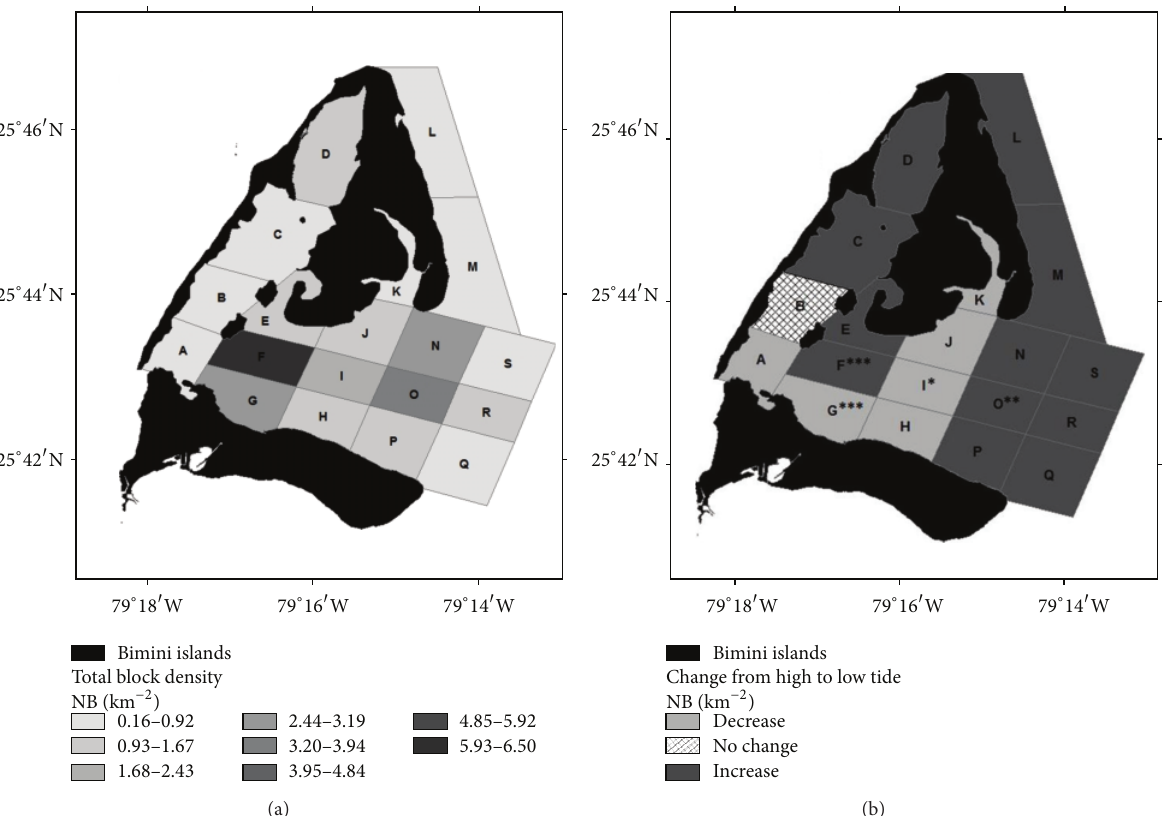
Figure 4: (a) Mean lemon shark block abundance for all surveys conducted; (b) change in block lemon shark count per unit effort (UE) from high-tide to low-tide surveys. Dark grey blocks represent an increase in count per UE; light grey block represents a decrease in count per UE; patterned block represents no change in count per UE, 𝜒 2 significant ∗ 𝑃 < 0.05 , ∗∗ 𝑃 < 0.01 , ∗∗∗ 𝑃 < 0.001